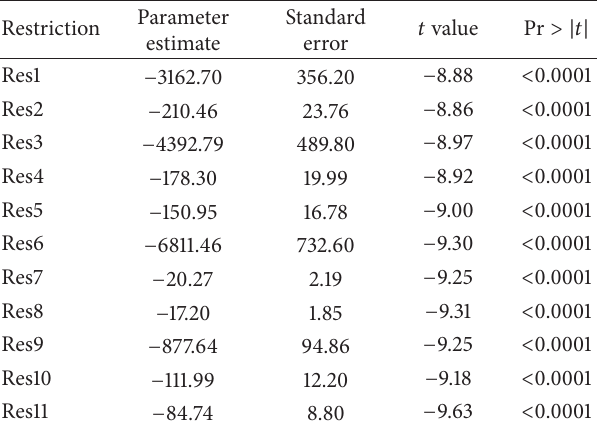
Table 10: t -test for the restriction imposed for weighted NSUR.